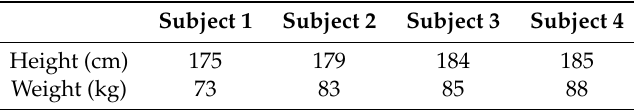
Table 2. Body sizes of four human